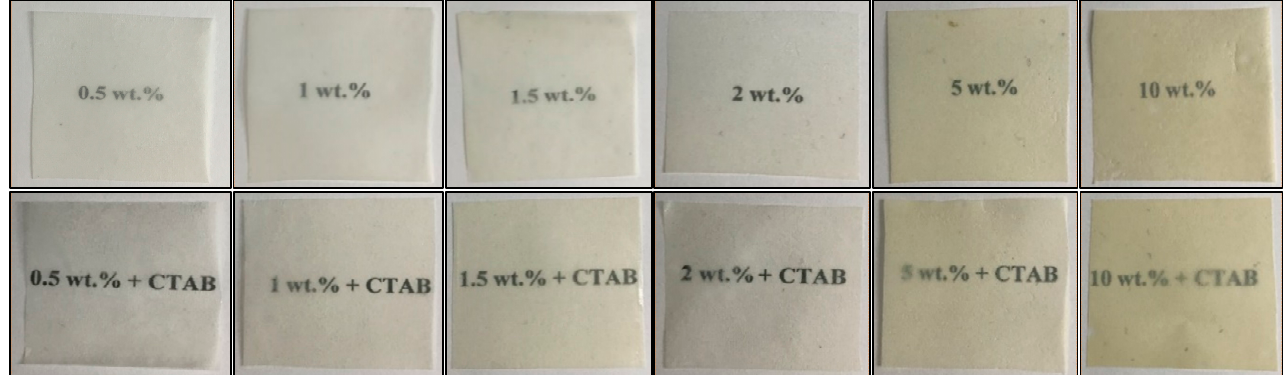
Figure 8. Comparison of the visual aspect of electrospun poly(3-hydroxybutyrate-co-3-hydroxyvalerate) (PHBV) films loaded with cerium oxide nanoparticles (CeO 2 NPs) and hexadecyltrimethylammonium bromide (CTAB). Table 1. Optical characterization expressed in terms of the color parameters (a*, b*, L*, and Δ E*) and transparency results of electrospun poly(3-hydroxybutyrate-co-3-hydroxyvalerate) (PHBV) films loaded with cerium oxide nanoparticles (CeO 2 NPs) and hexadecyltrimethylammonium bromide (CTAB).